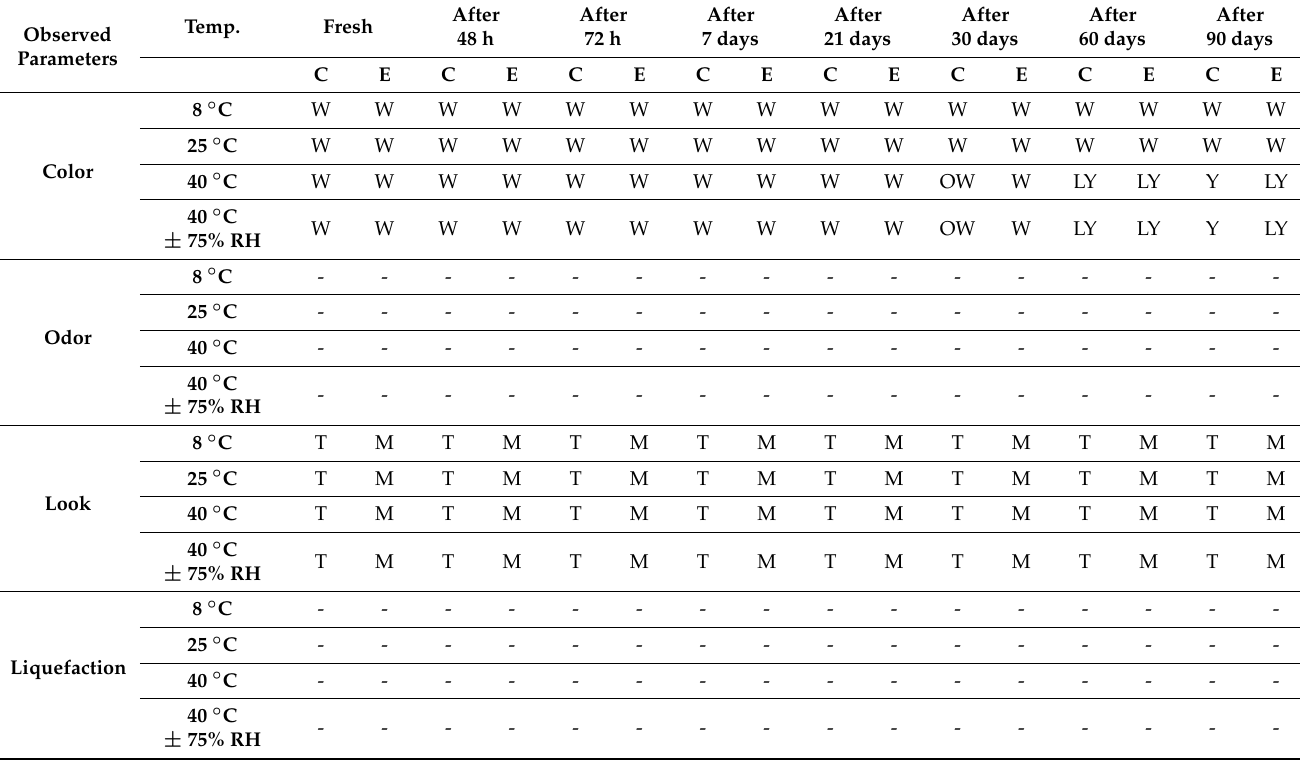
Table 3. Thermostability of TAEG (TA-5, E) and TACG (C) at 8 ◦ C, 25 ◦ C, 40 ◦ C, and 40 ◦ C ± 75% RH for a study period of three months (90